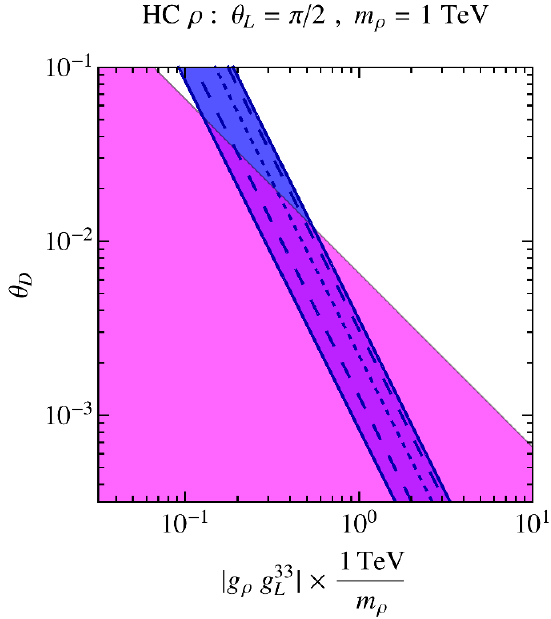
j and (cid:18) D for the (cid:12)xed value (cid:18) L = (cid:25)= 2 (\right-side" Figure 3 . The allowed range in terms of j g (cid:26) g 33 L spot). Conventions of the plots are the same as in (cid:12)gure 2. Figure 4 . Summary plot for constraints from the EW precision measurements and from the (cid:13)avor observables on the ( g (cid:26) g 33 ; m (cid:26) ) plane (cid:12)xing g (cid:26) = 6 for (cid:18) L . (cid:25)= 4 (left) and (cid:18) L (cid:24) (cid:25)= 2 (right). The L (darker) gray region is allowed by the EW precision measurements at 95% (68%) C.L. The regions in red (blue) line boundaries are favored by the b ! s(cid:22) + (cid:22) (cid:0) data that satis(cid:12)es all the other (cid:13)avor constraints, for (cid:18) L . (cid:25)= 4 ( (cid:18) L (cid:24) (cid:25)= 2). { 30